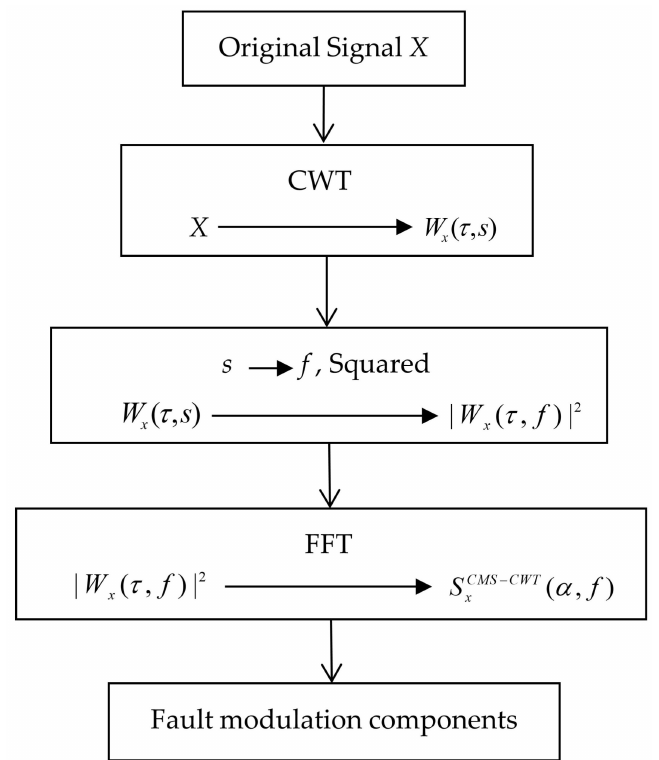
Figure 1. The flowchart of the proposed